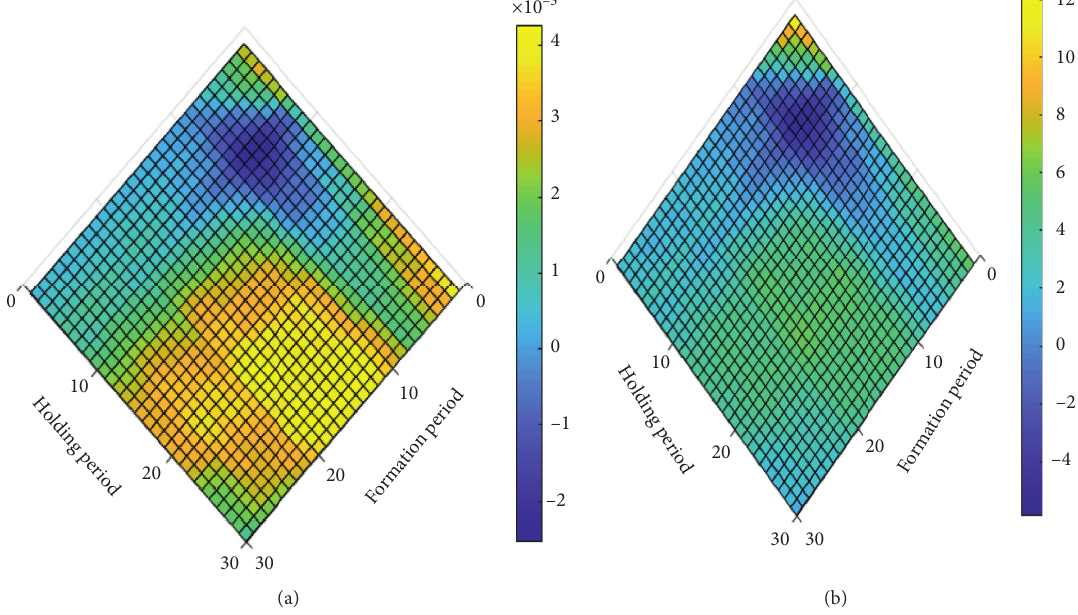
Figure 7: Momentum profits of the B-share market as a whole. This figure plots the momentum profits and related t -statistics of the B-share market as a whole. The formation and holding periods, respectively, range from 1 day to 30 days. (a) Momentum profit and (b) t